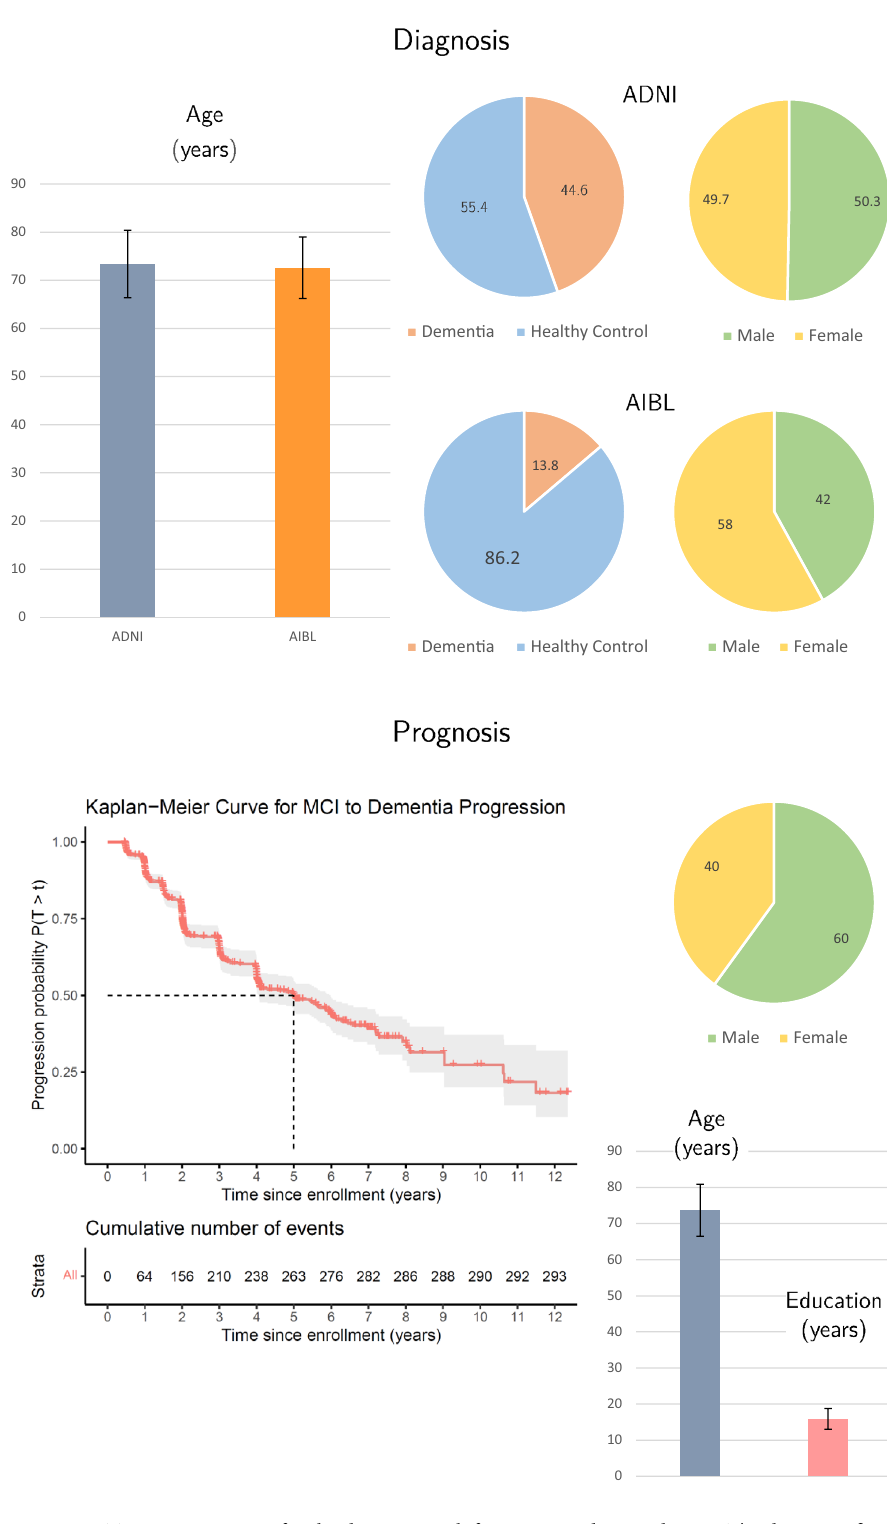
Figure 2. Top: Data statistics for the diagnosis task for ADNI and AIBL dataset. The data stratification strategy has been done according to three variables: age, sex and diagnosis. The total number of samples is 1505 for ADNI and 552 for AIBL. Bottom: Data statistics for the prognosis task. The data stratification across t the sets has been following 4 variables: time-to-dementia, sex, age and years of